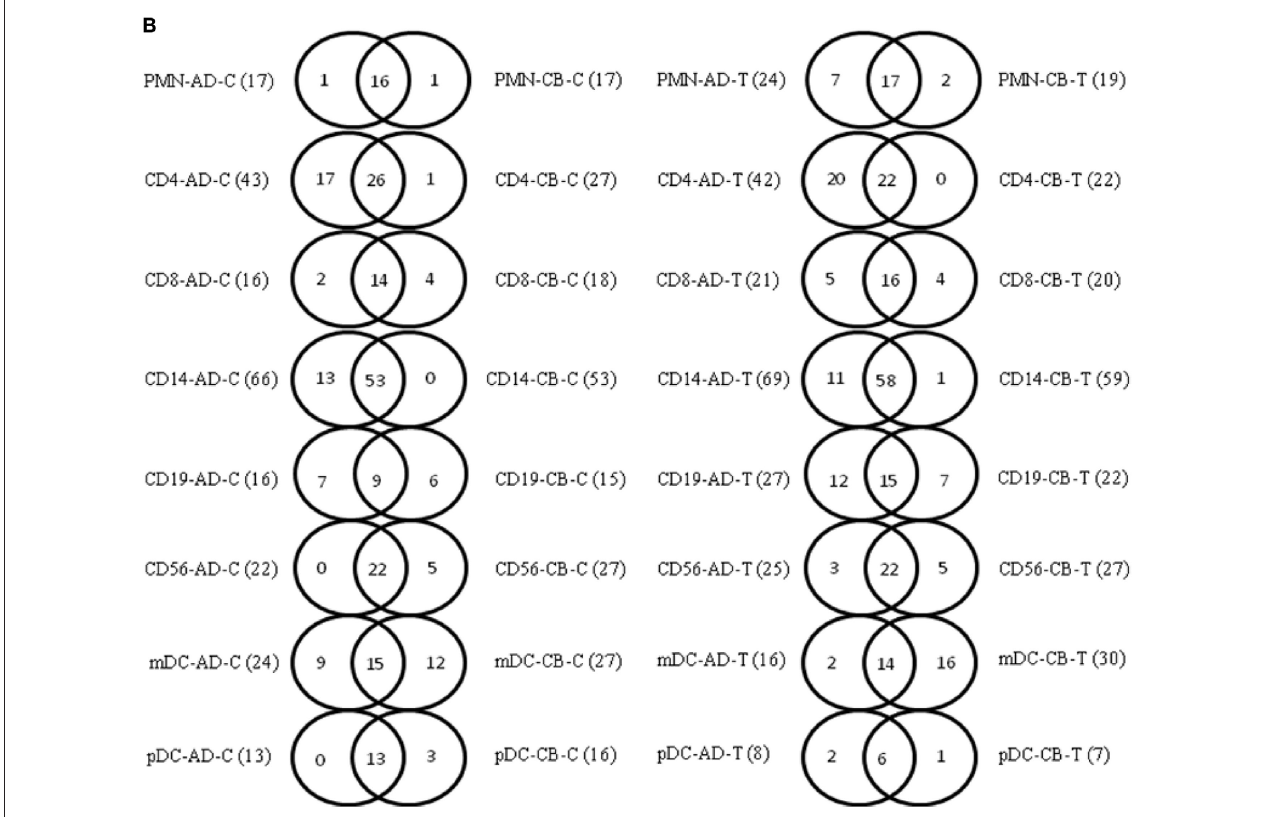
FigUre 2 | continued (a) Venn diagrams showing comparative analysis of common and unique miRNA transcripts in the corresponding adult and cord blood (CB) leukocyte subsets (array intensity log 2 greater than 6). (B) Venn diagrams showing comparative analysis of common and unique miRNA transcripts in the corresponding adult and CB leukocyte subsets (array intensity log 2 greater than 10). Abbreviations: AD-C, adult blood cells without stimulation; CB-C, cord blood cells without stimulation; AD-T, adult blood cells with stimulation; CB-T, cord blood cells with